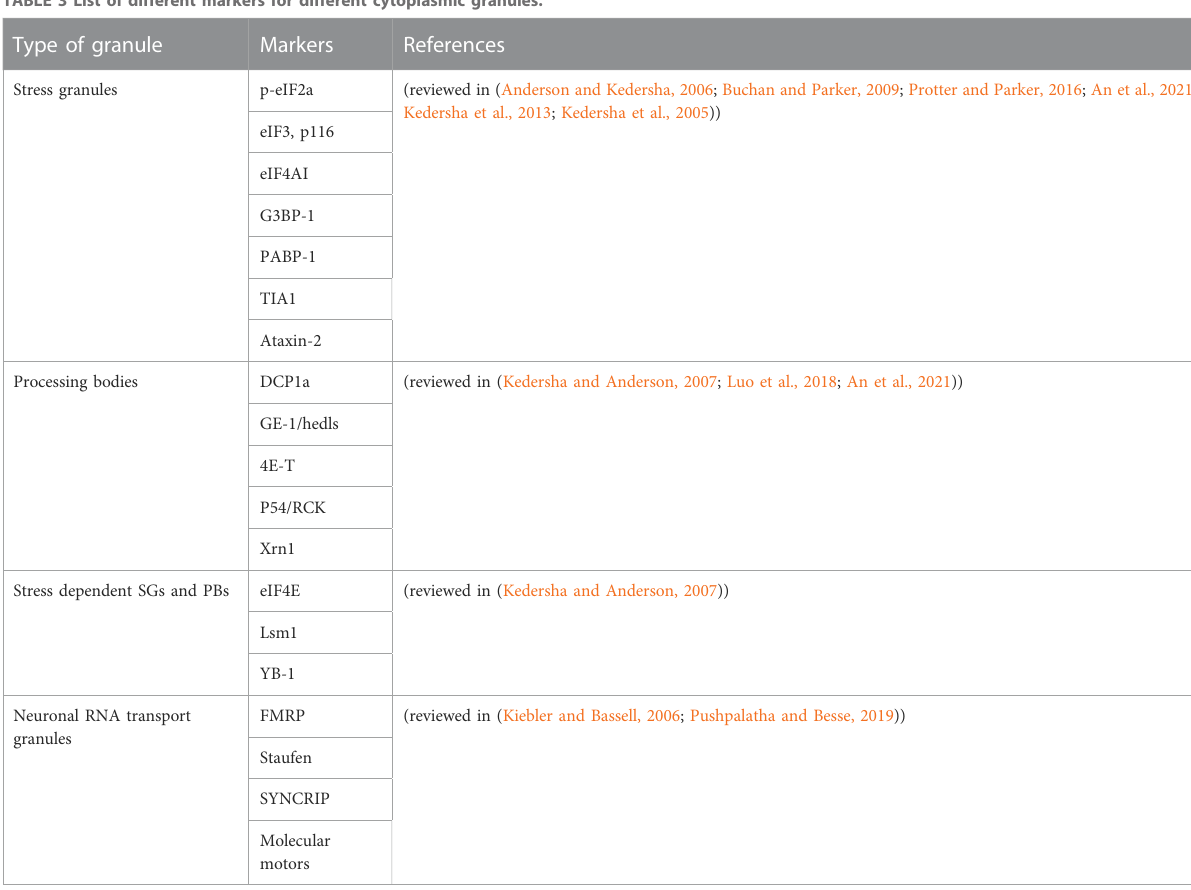
TABLE 3 List of different markers for different cytoplasmic